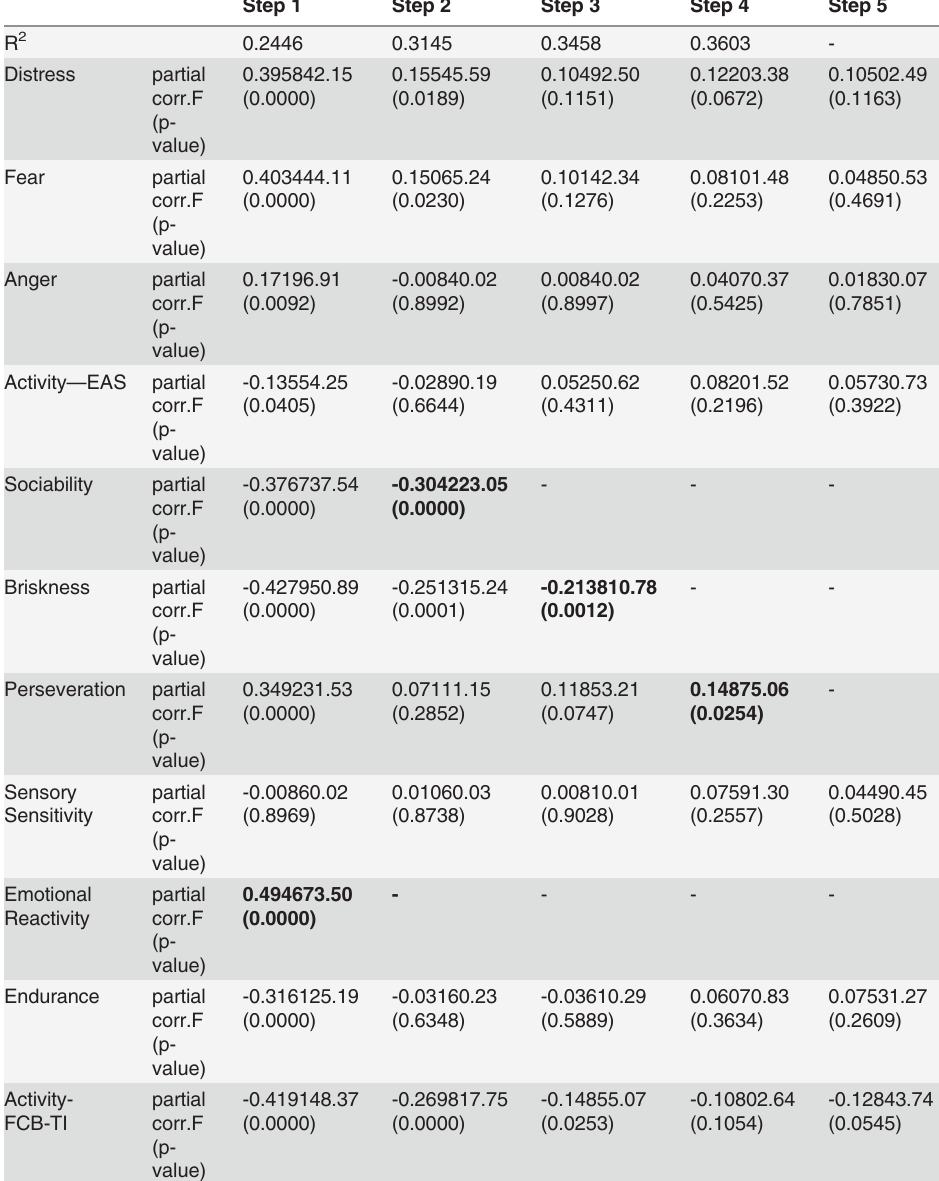
Table 4. Results of Forward Entry Selection Regression Analysis in a group of males, involving Total- AQ variable as a predicted parameter and EAS-TS and FCB-TI scales as